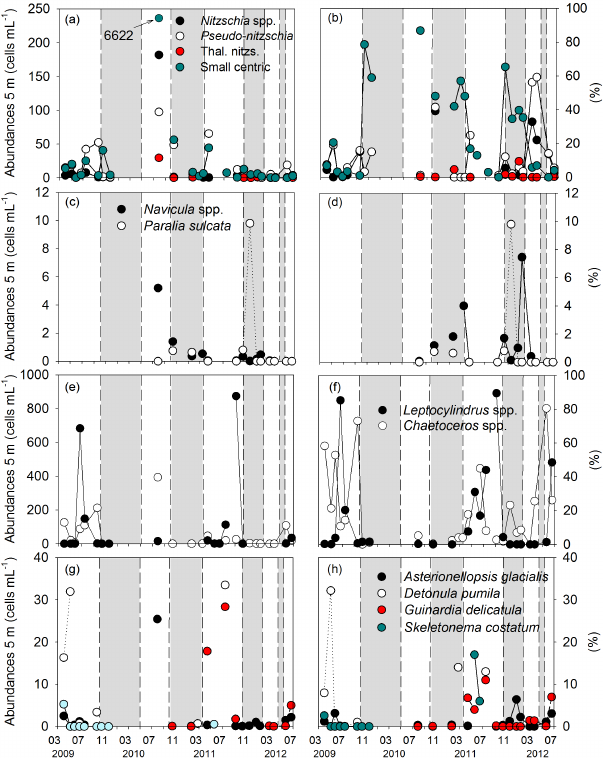
Figure 4. Time series of water column diatom abundances (a, c, e, g) and assemblages (b, d, f, h) from water column sam- ples recovered at 5m water depth. Water column diatom species were grouped in order to easily compare them with fossil di- atom assemblage from the sediment trap samples. Nitzschia spp: Nitzschia longissima ; Pseudo-nitzschia spp: Pseudo-nitzschia cf. delicatissima and Pseudo nitzschia cf. seriata ; Thal. nitzs: Thalas- sionema nitzschioides ; small centric includes centric diatom cells whose diameter did not allow for species identification and Thalas- siosira spp. small; Navicula spp: Navicula transitans var. derasa ; Chaetoceros (Ch.) spp: Ch. curvisetus , Ch. socialis , Ch. didymus , Ch. laciniosus , Ch. decipiens and small Chaetoceros ; Leptocylin- drus spp: Leptocylindrus danicus . Upwelling and downwelling pe- riods are highlighted with white and grey bars, respectively, based on upwelling index and biogeochemical data presented in Zúñiga et al. (2016). The number and the corresponding arrow in Fig. 4a refer to small centric cells abundance in July